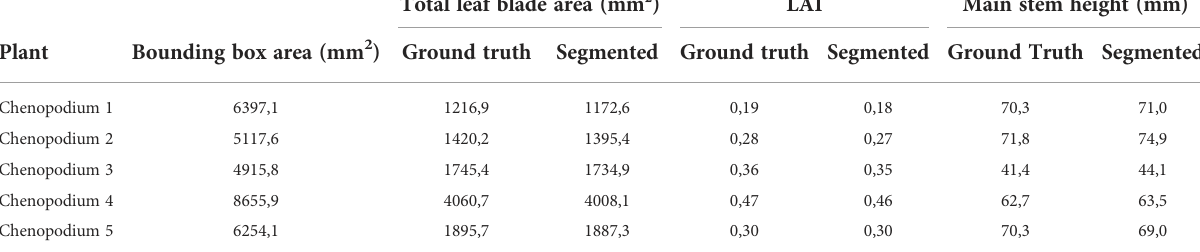
TABLE 5 Comparison of total leaf blade areas and LAI values between the ground truth and the segmentation performed on 5 real Chenopodiums, as well as comparison of the main stem height computed on 5 synthetic Chenopodiums on ground truth and segmented models. Total leaf blade area (mm²)